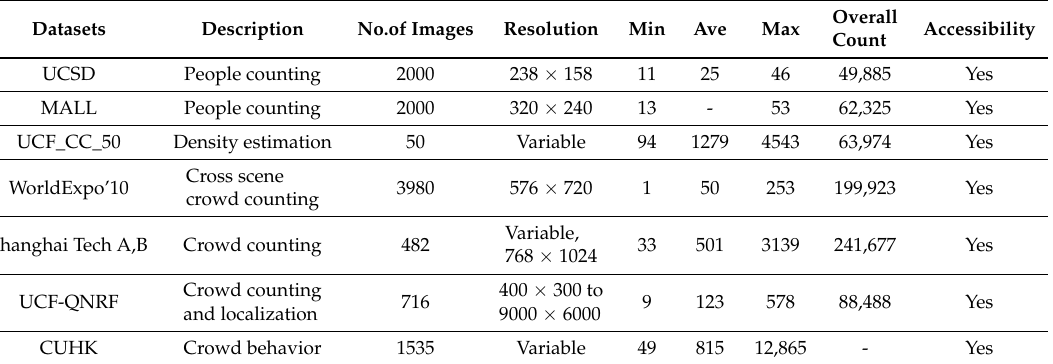
Table 1. Description of